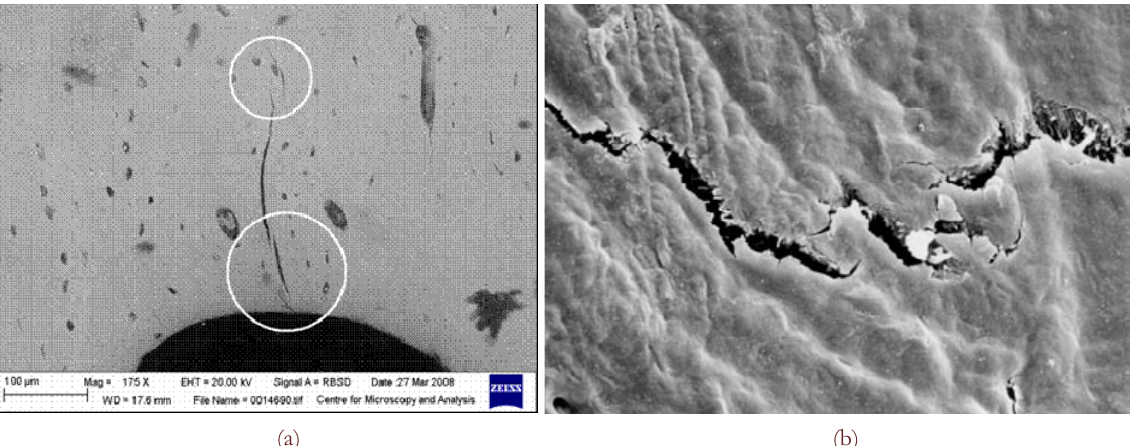
Figure 4: Two SEM images showing cracks in bone which display bridges consisting of uncracked ligaments across the crack faces. Photo (a) from tests conducted in our laboratories by Stewart Mahoney; photo (b) from [19].